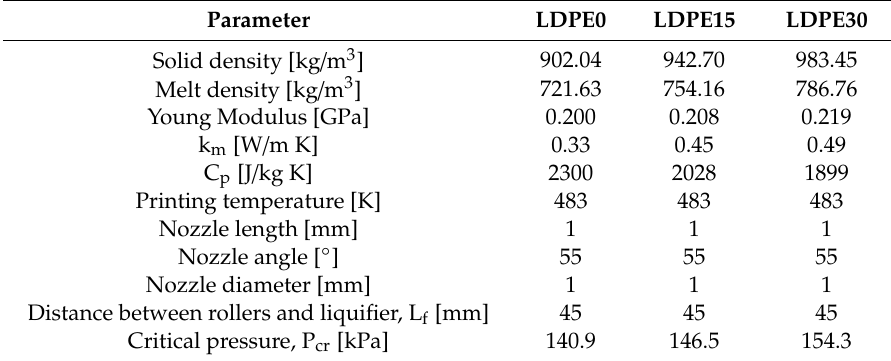
Table 6. Parameters used in mathematical modeling of FDM process feed rate for the neat LDPE and for the obtained